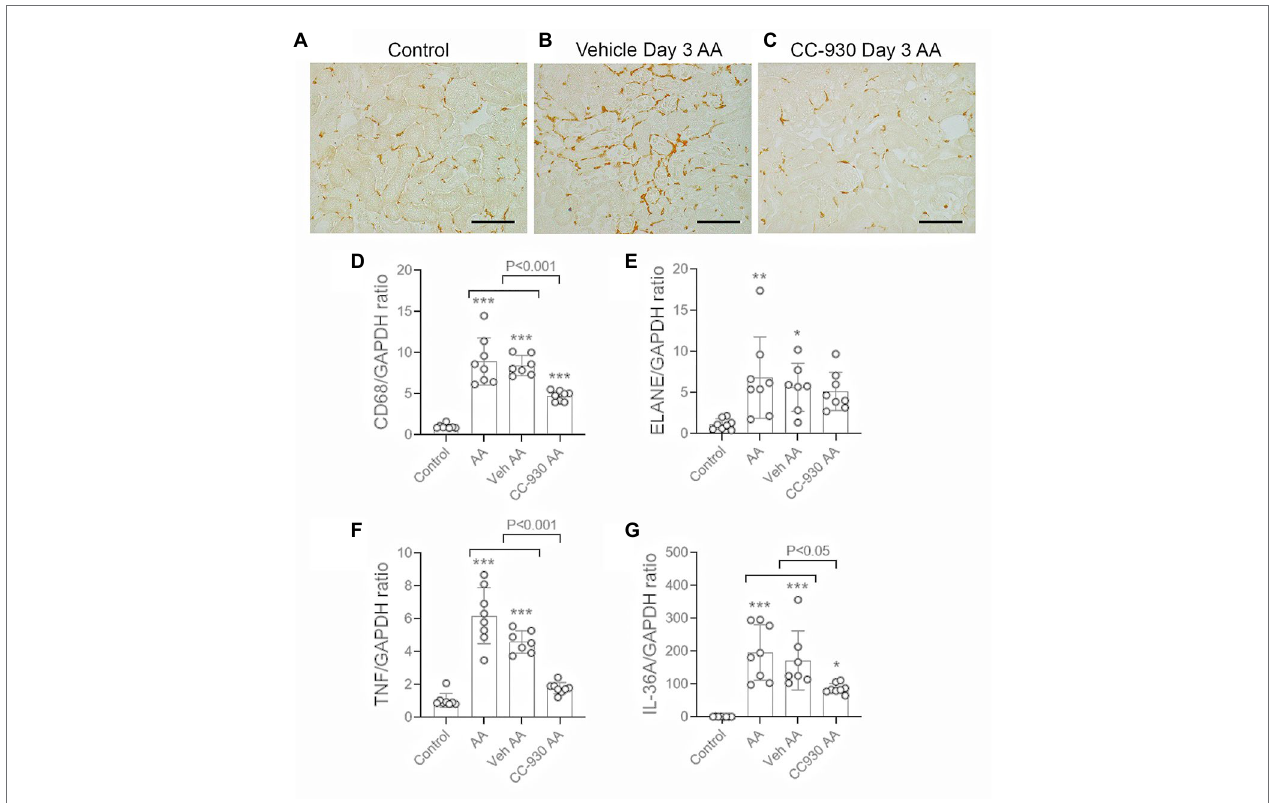
FIGURE 4 | Macrophage infiltration and inflammation on day 3 of AA-induced acute kidney injury. AA injected mice were either untreated (AA), or treated with vehicle (Veh AA) or CC-930 (CC-930 AA) and compared to normal controls. (A-C) Immunohistochemistry staining for F4/80+ macrophages. (A) Normal control kidney shows a regular network of resident kidney macrophages. (B) Vehicle treated AA shows a significant increase in F4/80+ macrophages, mainly around damaged tubules. (C) CC-930 treated AA showing a reduction in the number of infiltrating macrophages. Bars represent 100 μ m. (D – G) RT-PCR analysis of kidney tissue for: (D)